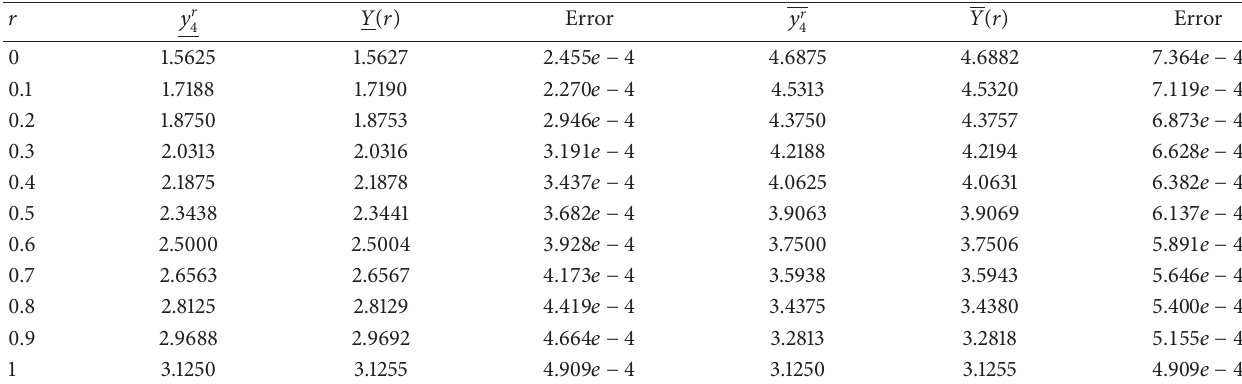
Table 1: The result of the proposed method for Case 1 of Example 52 with 𝛼 = 0.85 and 𝑚 = 4 .